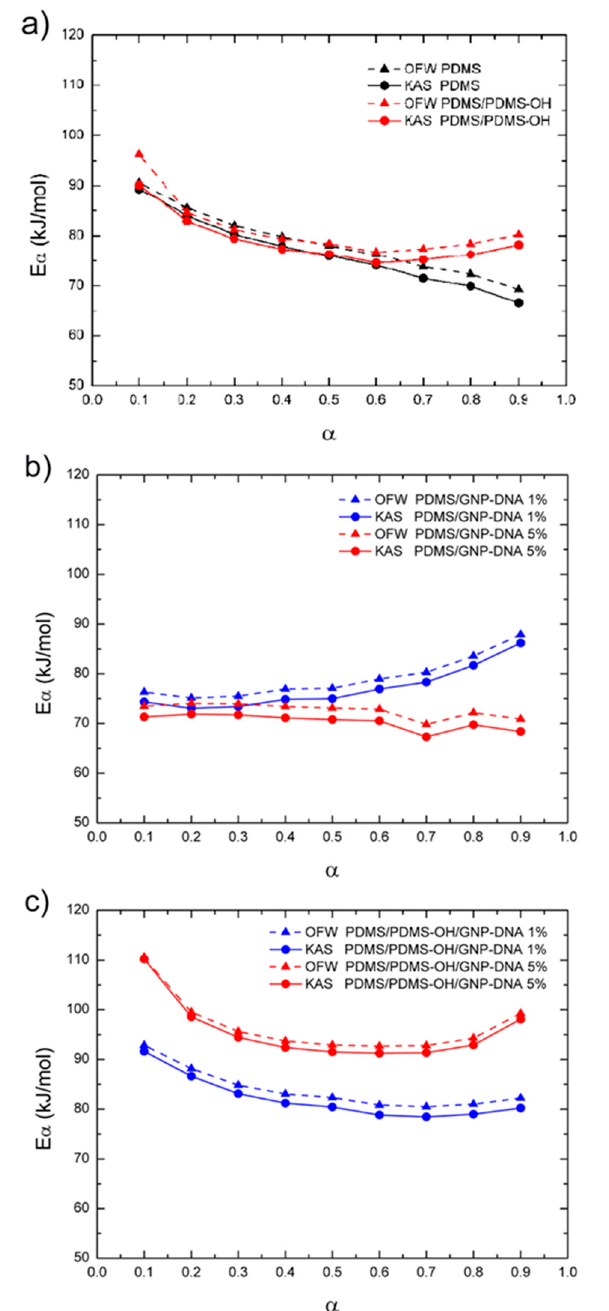
Figure 8. Activation energies (E α ) of the curing process of ( a ) the unfilled PDMS matrix